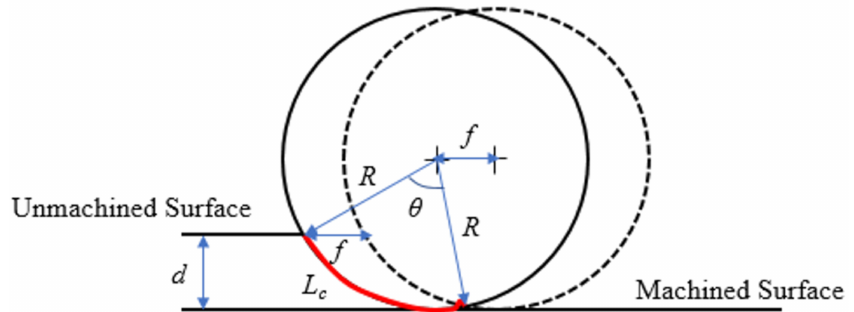
Figure 3. Cutting tool interacts with workpiece (top view)